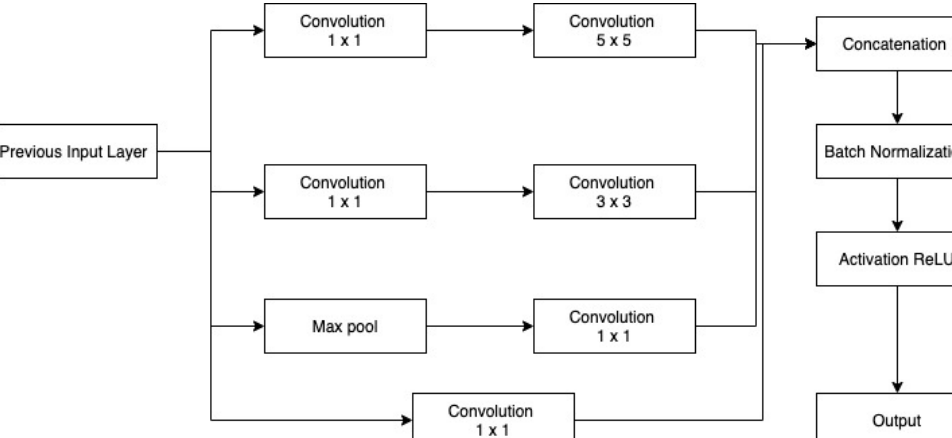
Figure 5. MI: Inception block 2.